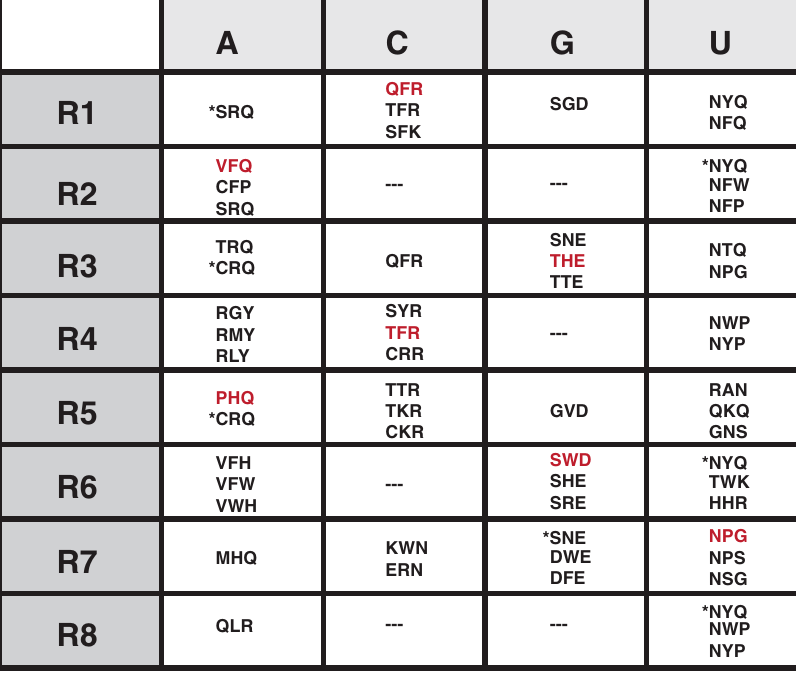
Fig. 4 Summary of the best TRM combinations for each PUF repeat. These TRM combinations follow one of three criteria: (1) used in the wild-type Pumilio-1 PUF domain, indicated by * in the fi gure; (2) highly speci fi c in both the random screen and targeted screen; or (3) best represent the pattern of the sequence logo in Fig. 3. The rows indicate each repeat position of the Pumilio-1 PUF domain, and the columns indicate the four RNA bases at the cognate positions. Red, TRM combinations used in the PUF domain designs; ---no highly base-speci fi c TRM combination